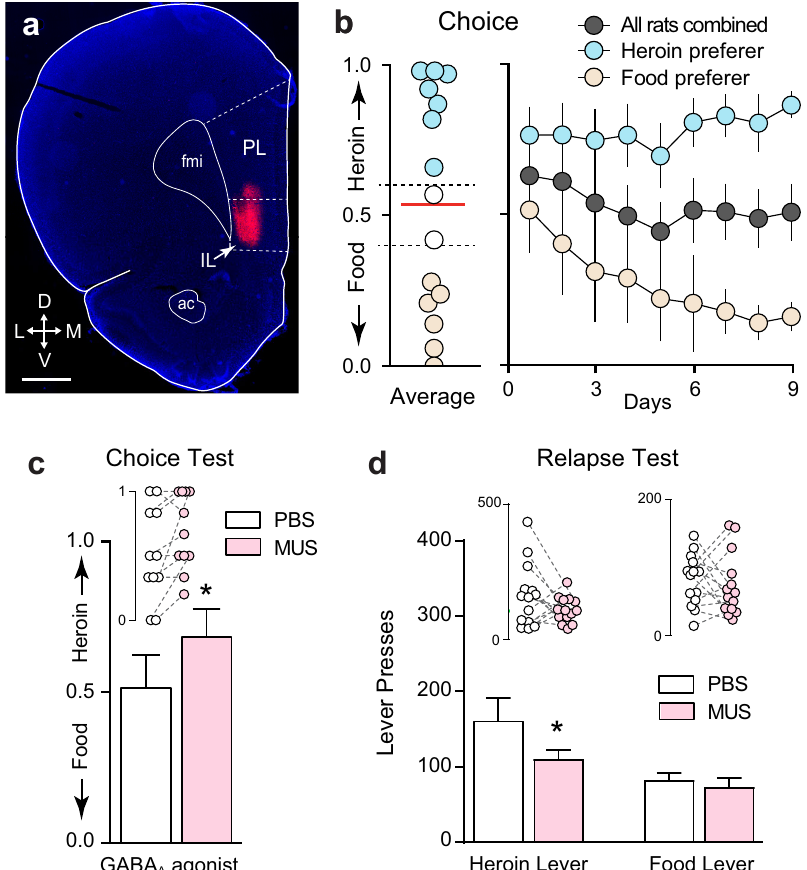
Fig. 3 Silencing IL neurons differentially alters heroin choice and relapse. a Representative micrograph showing cannula placement and infusion of the fl uorescent GABA = 1000 µ m). PL prelimbic cortex, fmi forceps minor of the corpus callosum, ac A receptor agonist muscimol (MUS) into IL (scale bar anterior commissure, arrows indicate anatomical orientation along with dorsoventral (DV) and mediolateral (ML) axes. b Overall rats choose heroin and food equally, but distinct populations of rats become heroin preferring ( n = 7) or food preferring ( n = 6) over time. c Muscimol microinjection into IL potentiates heroin preference during choice (two-tailed paired t -test, t (10) = 2.39, p = 0.04; n = 11 rats). d Muscimol microinjection reduced cued relapse during a test in which both food and heroin levers and cues were present but rewards were unavailable (two-way ANOVA F (1,13) = 11.70, p = 4.56 × 10 − 3 , Bonferroni post hoc test, p = 0.04; n = 14 rats). * p < 0.05 comparing between vehicle and MUS. Data represented as mean ±